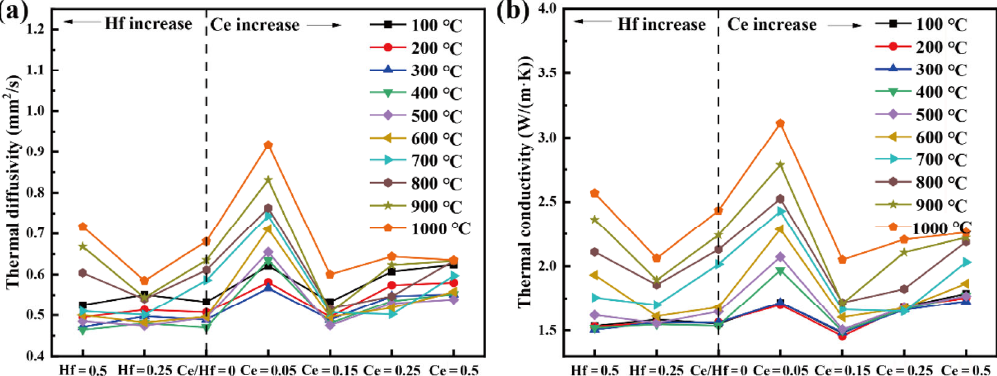
Fig. 8 Thermophysical properties of A 2 B 2 O 7 high-entropy ceramics: (a) thermal diffusivity; (b) thermal